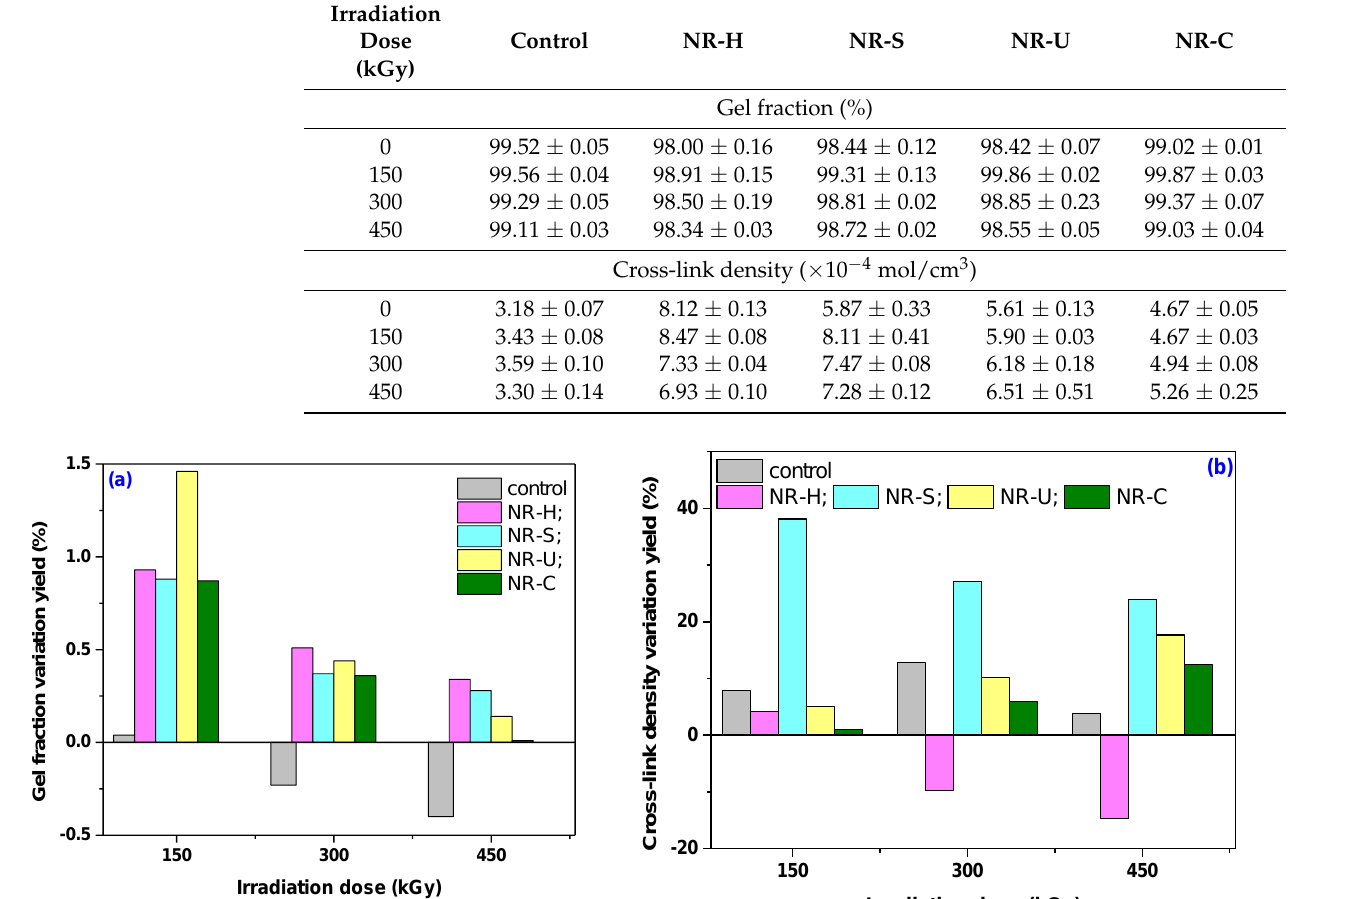
Table 4. The gel fraction and cross-link density variation as a function of irradiation dose and filler type.